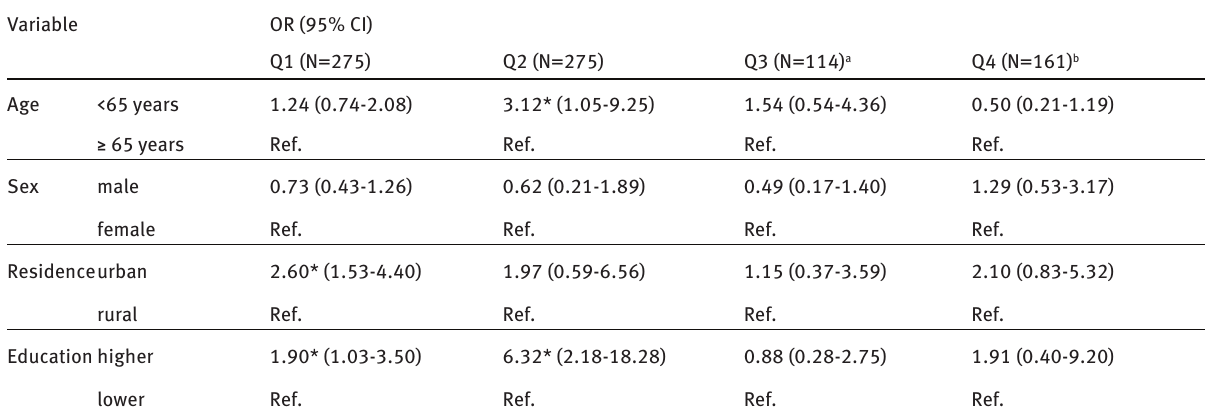
Table 1: Socio-demographic predictors of awareness about screening methods, sources of information, and patients’ attitude towards participation in screening programs